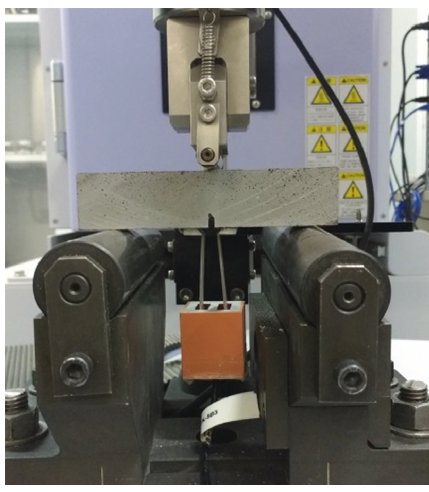
Figure 1: Experimental setup used to measure flexural strength by three-point